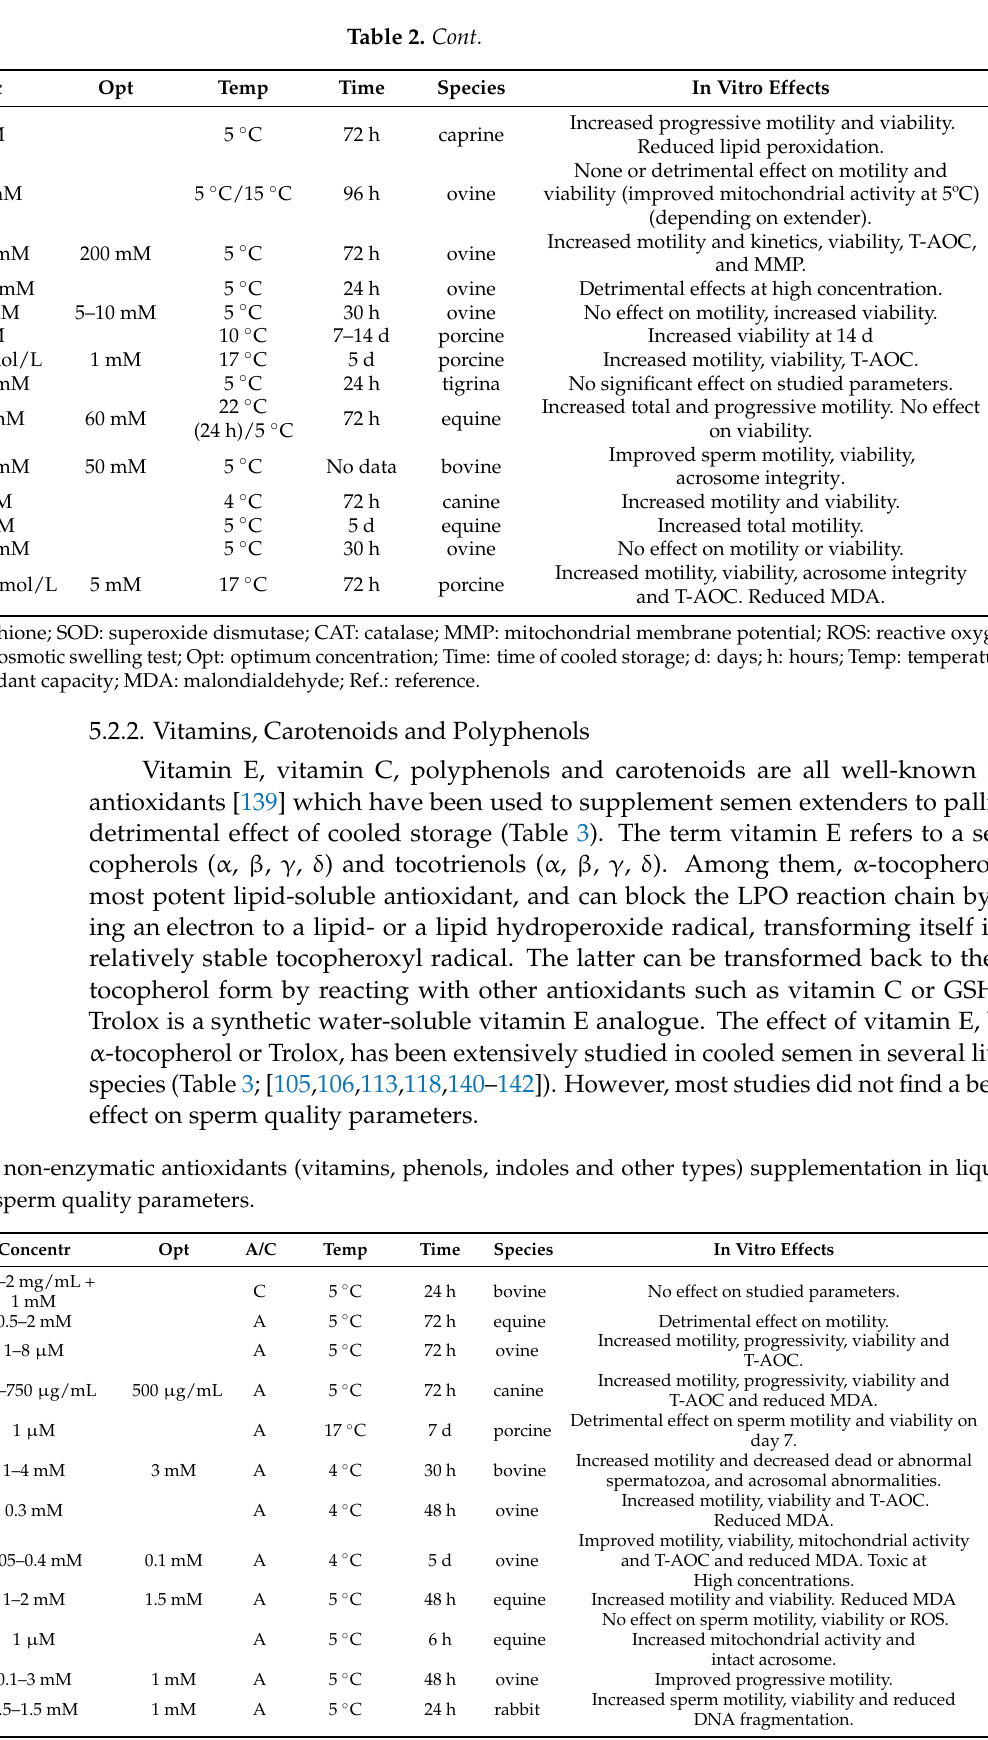
Improved motility, viability, mitochondrial activity ovine and T-AOC and reduced MDA. Toxic at High concentrations. Increased motility and viability. Reduced MDA No effect on sperm motility, viability or ROS. Increased mitochondrial activity and intact acrosome. Improved progressive motility. rabbit Increased sperm motility, viability and reduced DNA